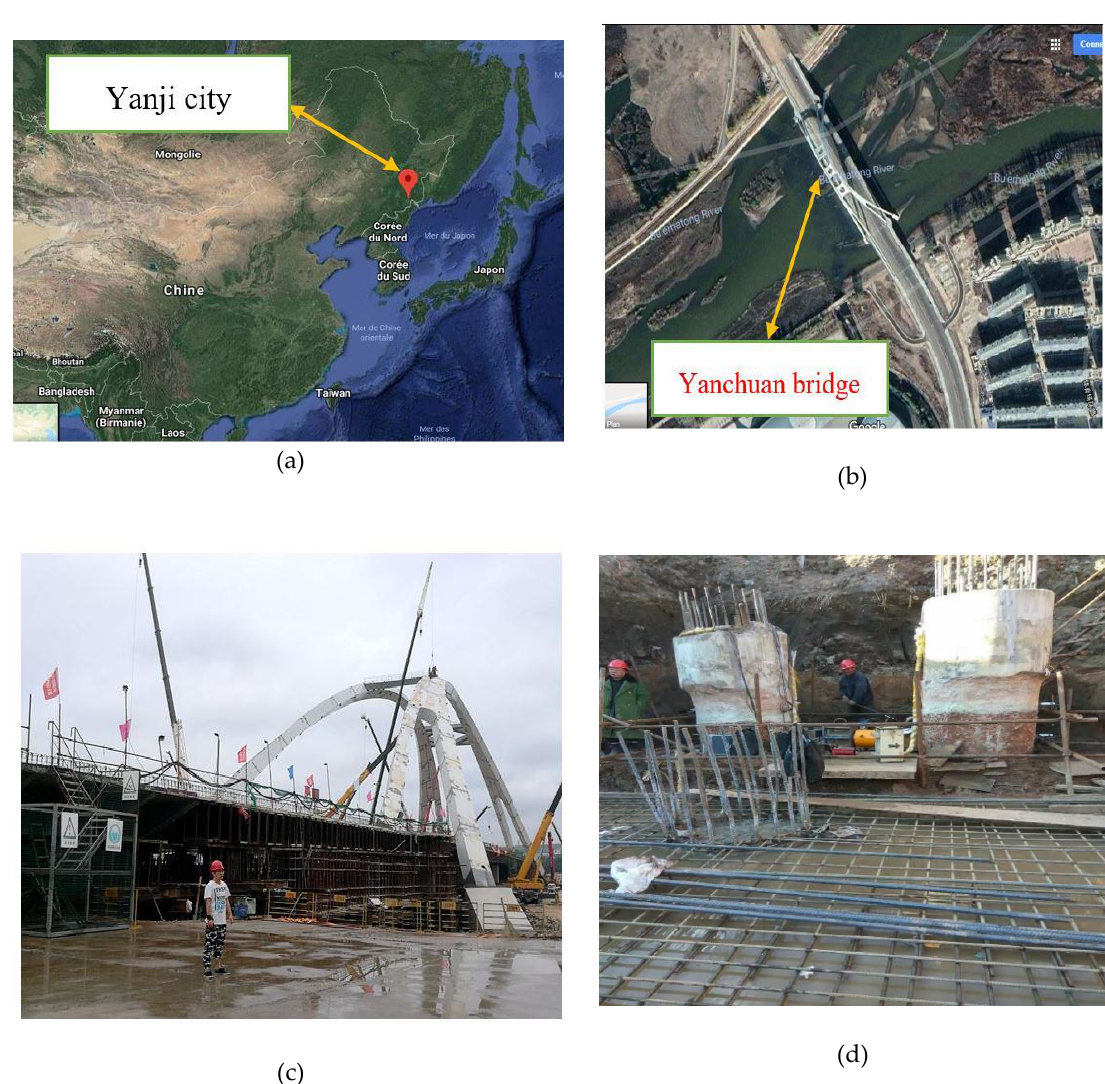
Figure 1. The geo-localization of the Yanchuan Bridge. ( a )the Yanji city locate in china, ( b ) location of construction at Yanji city, ( c ) construction view of the bridge, ( d ) view of the pile test.